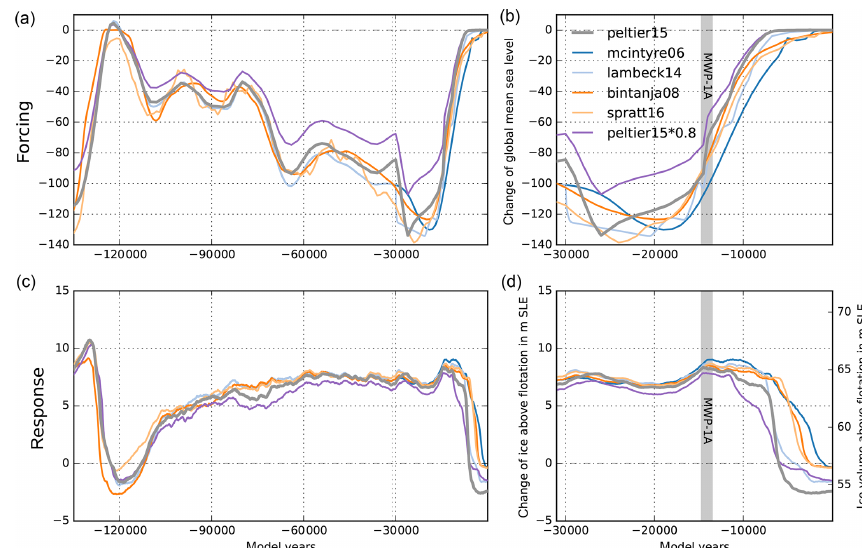
Figure 18. Time series of reconstructed sea-level change over the last 135kyr (a) and the last 30kyr (b) by Stuhne and Peltier (2015), Imbrie and McIntyre (2006), Lambeck et al. (2014), Bintanja and Van de Wal (2008), and Spratt and Lisiecki (2016) and corresponding PISM-simulated sea-level-relevant ice volume anomaly relative to observations (Fretwell et al., 2013) in (c) and (d) . In order to approximate the effect of self-gravitation we scaled the ICE-6G forcing (Stuhne and Peltier, 2015) by 80%. For about 25m higher sea-level stand at LGM we find almost the same modeled ice volume, while we find earlier but more gradual deglaciation